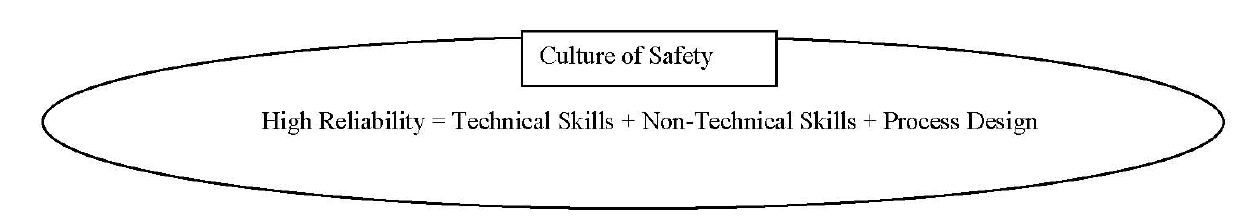
Figure 1. Model for high reliability teams